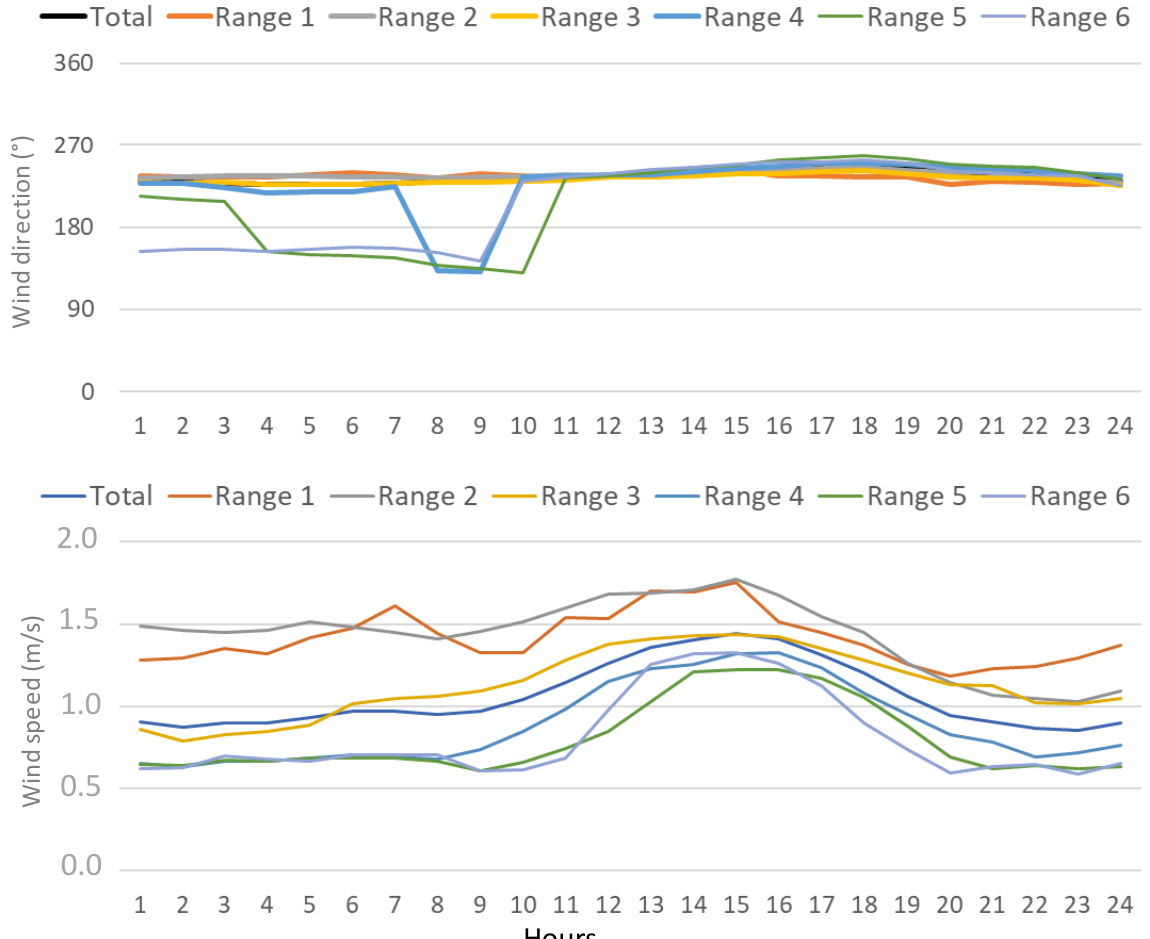
Figure 7. Daily cycles of wind direction ( top ) and speed for each range ( bottom ).